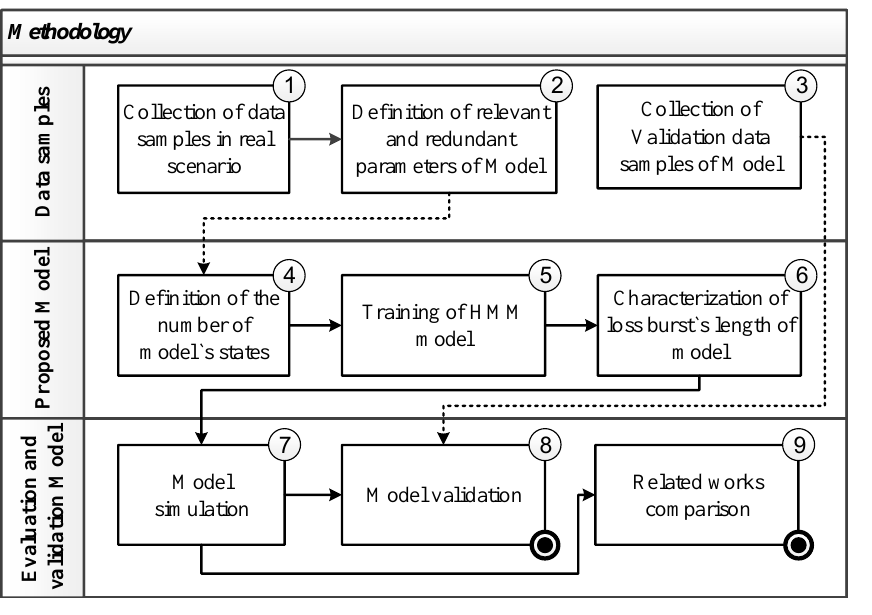
Figure 1. Methodology of this